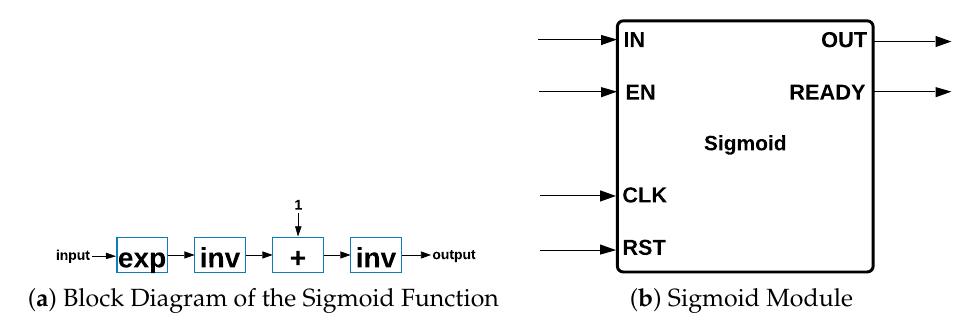
Figure 5. Block Diagram and Module of the Sigmoid Function.